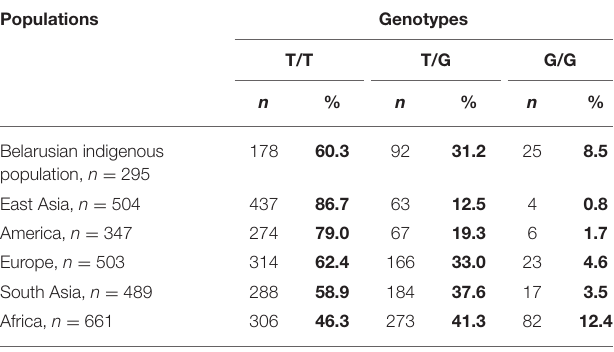
Structure of presented populations is identical to that in Figure 1 . Bold values indicate the mean statistical significance or % value.